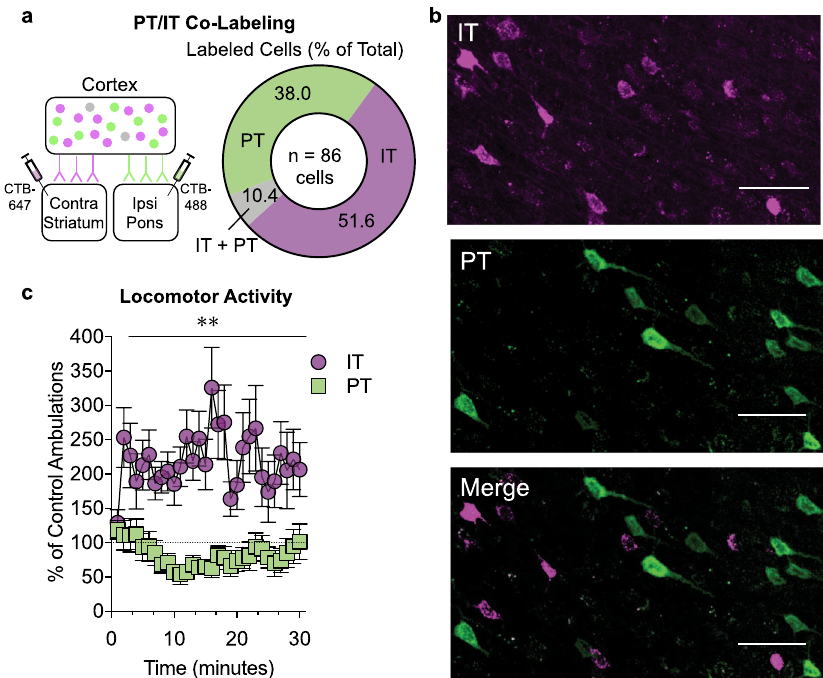
Fig. 2 PT and IT neurons in ACC are anatomically and functionally distinct. a Left: Viral strategy for anatomical tracing of IT and PT neurons with CTB ( N = 3). Right: Quanti fi cation of neuronal labeling. Thirty-eight percent of labeled cortical neurons are PT + (green), ~52% are IT + (magenta), and ~10% are co-labeled from 86 total cells counted. b Representative photomicrographs of neuronal labeling of IT cells (top), PT cells (middle), and a merged image (bottom). Scale bar = 50 μ m. c Line graphs where data points represent the mean ± SEM percent of control (vehicle DREADD, N = 11 – 12) ambulations induced by a compound stimulus (novelty + 15 mg/kg cocaine, i.p.). IT inhibition (magenta, N = 14) signi fi cantly increased and PT inhibition (green, N = 11) signi fi cantly decreased the percent of control activity, indicating that the cell types are functionally distinct. ** p < 0.001, group × time interaction, two-way RM